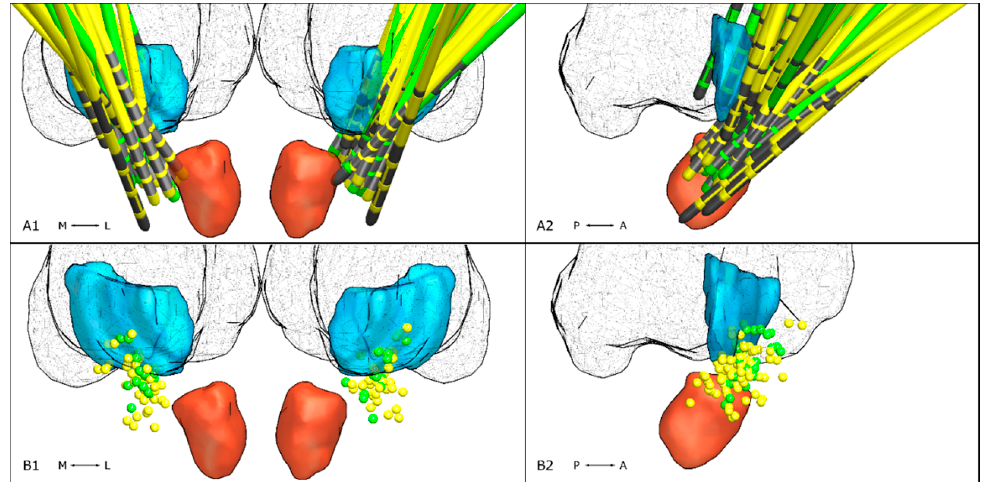
Figure 2. Lead locations in relation to the VIM (turquoise), the red nucleus (red) and thalamus (fishnet structure) taken from the DISTAL atlas implemented in LEAD DBS. In the top row, electrode locations of patients with ET (green) and ET-p (yellow) are shown bilaterally ( A1 ) and mirrored to the right hemisphere ( A2 ). Electrode contacts are marked in gray. In the bottom row, locations of active electrode contacts are shown bilaterally ( B1 ) and mirrored on the right hemisphere ( B2 ).